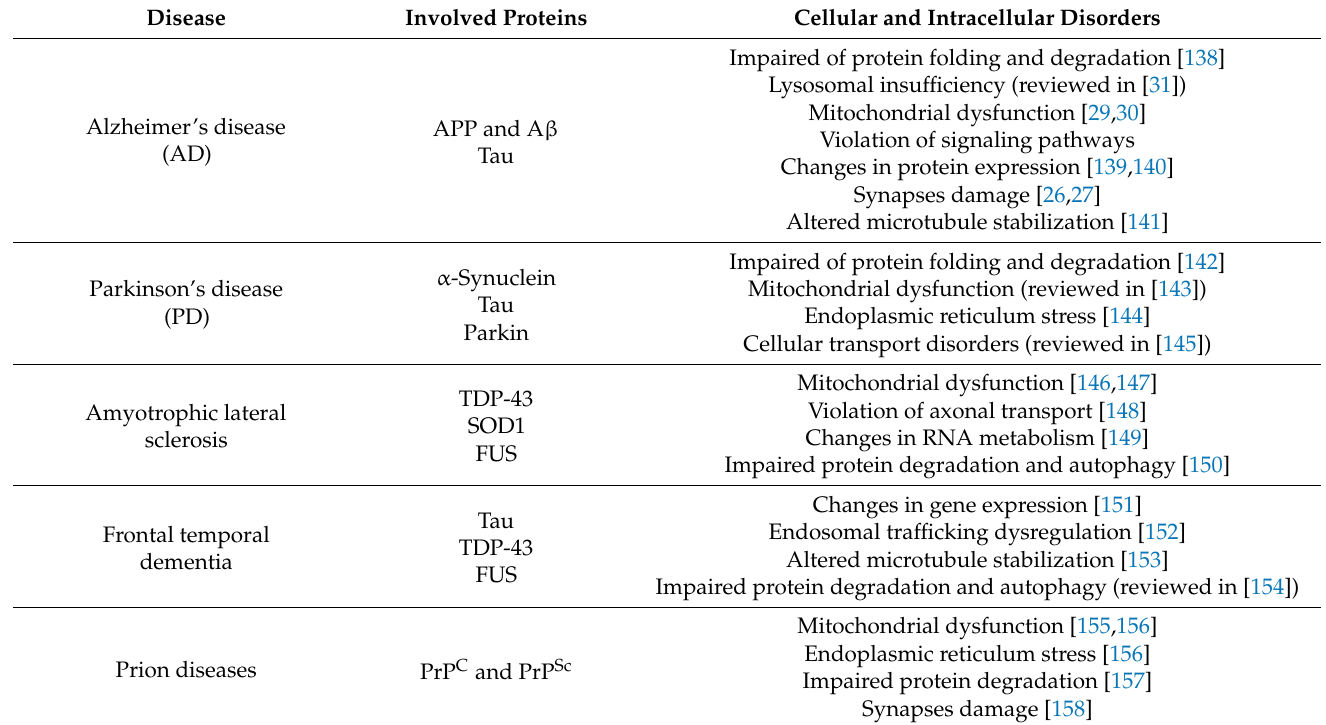
Table 1. Neurodegenerative diseases, proteins and cellular disorders, involved in neurodegenera- tion